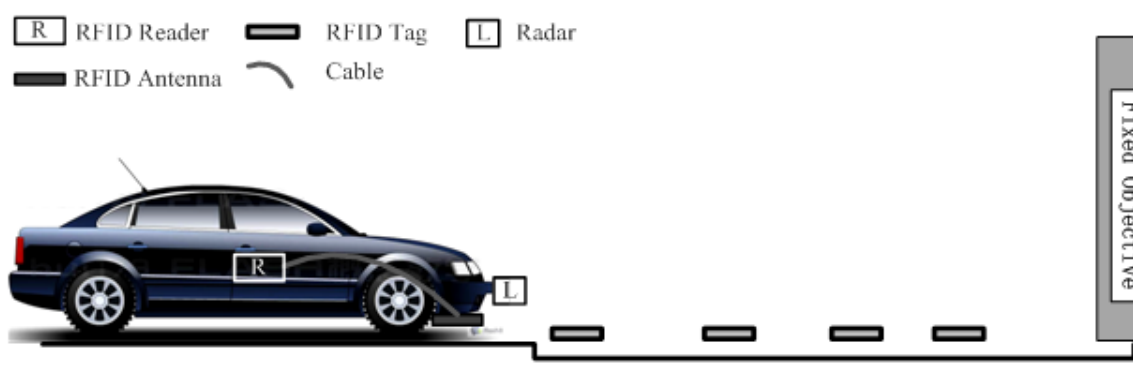
Figure 5. Setup of experimental verification based on